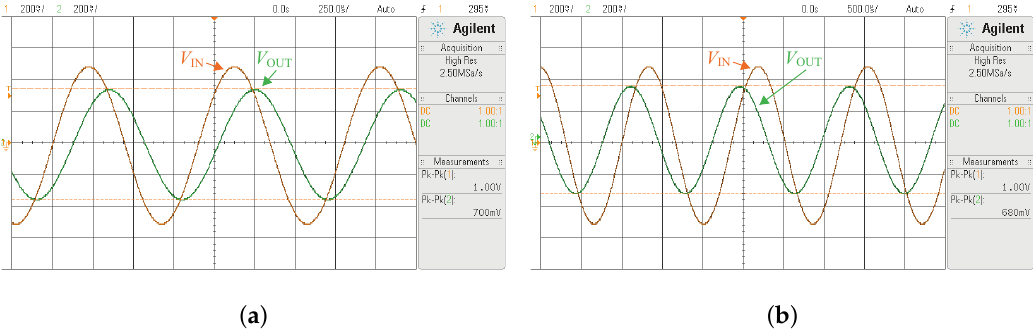
Figure 11. Input–output waveforms observed in oscilloscope for the proposed ( a ) LPPLF ( α = 0.5 ) with an input frequency of f H = 1.11 kHz, ( b ) HPPLF ( α = 0.5 ) with an input frequency of f H = 738 Hz.